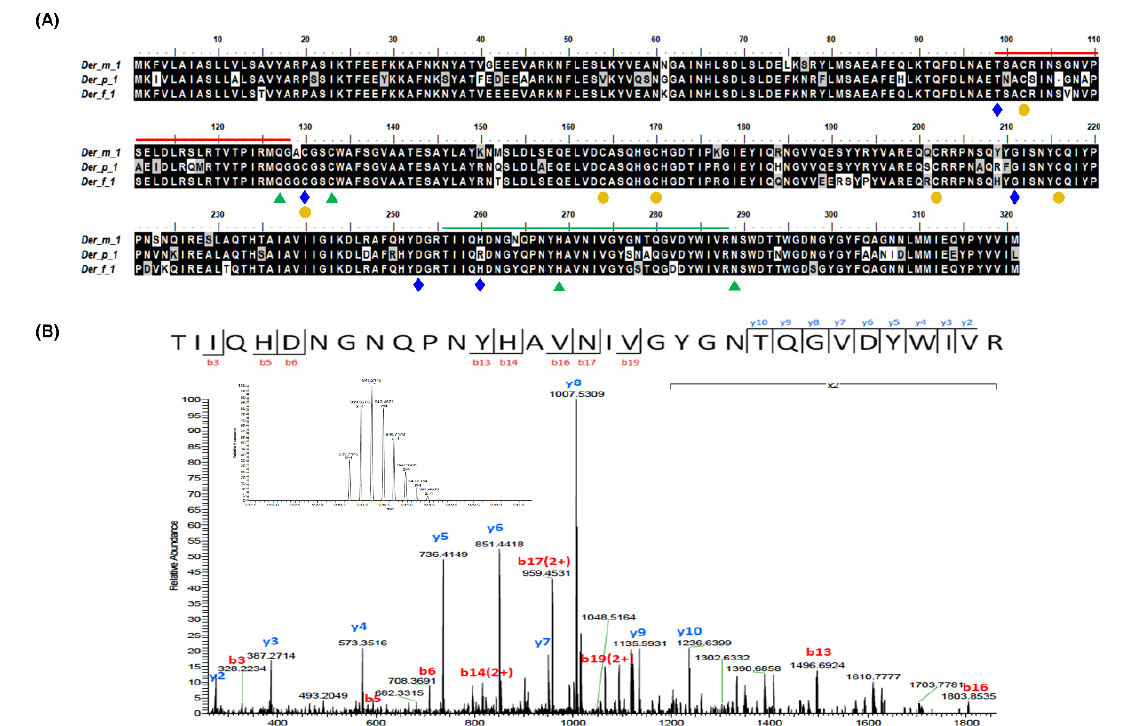
Figure 2. The alignment of putative protein sequence of Der m 1 with Der m 1 , Der f 1 , and Der p 1 in the Allergen Nomenclature database. ( A ) The open reading frame containing 231 Der m 1 protein was aligned with the Der m 1 sequence (P16312.1, 29 residues, ━ ) in the Allergen Nomenclature database. The putative Der m 1 sequence was aligned with Der f 1 (UniProtKB: P16311.2) and Der p 1 (P08176.2); the residues with white text on a black background show the identical residues. The five blue diamond symbols ( ◆ ) reveal the putative metal ion binding sites for ion-dependent protease activity predicted from NCBI conserved domain database (CDD). The six yellow circle symbols ( ● ) demonstrate the cysteine residues for disulfide bonds forming consistent with protein structures of Der p 1 and Der f 1 . Four green triangle symbols ( ▲ ) indicate the putative protease active center, green line ( ━ ) represents the unique peptide from LC-MS/MS spectra analysis. ( B ) Identification of triply charged precursor ions at m / z 803.73 of the unique peptide was performed using Orbitrap Elite Hybrid Liquid Chromatographic-tandem Mass Spectrometry (LC-MS/MS) equipped with a Waters nano-Acquity UPLC system. Raw LC-MS/MS data were searched through the Mascot search engine (version 2.2.0, Matrix Science) against putative Der m allergen proteins’ primary sequence from NGS analysis.